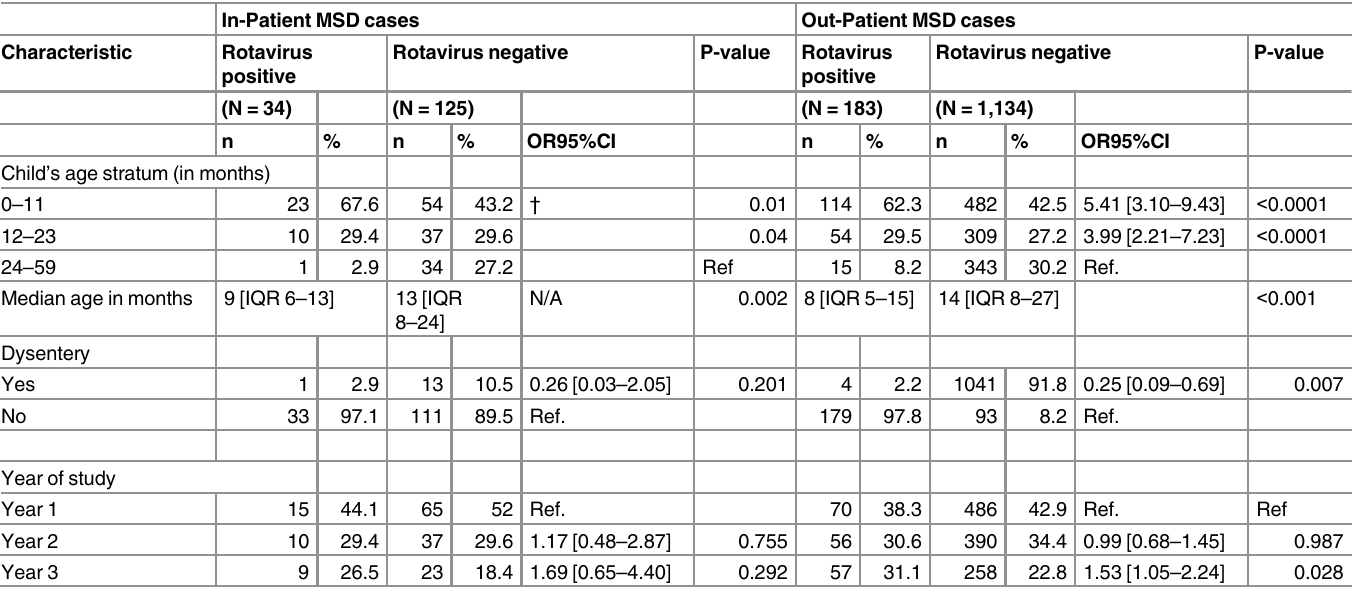
Table 1. Proportion of all rotavirus-positive vs negative stool samples from all GEMS children enrolled with MSD episodes within in-patient and out-patient departments during the first 3 years of non-interrupted enrollment, western Kenya, Jan 2008-Feb